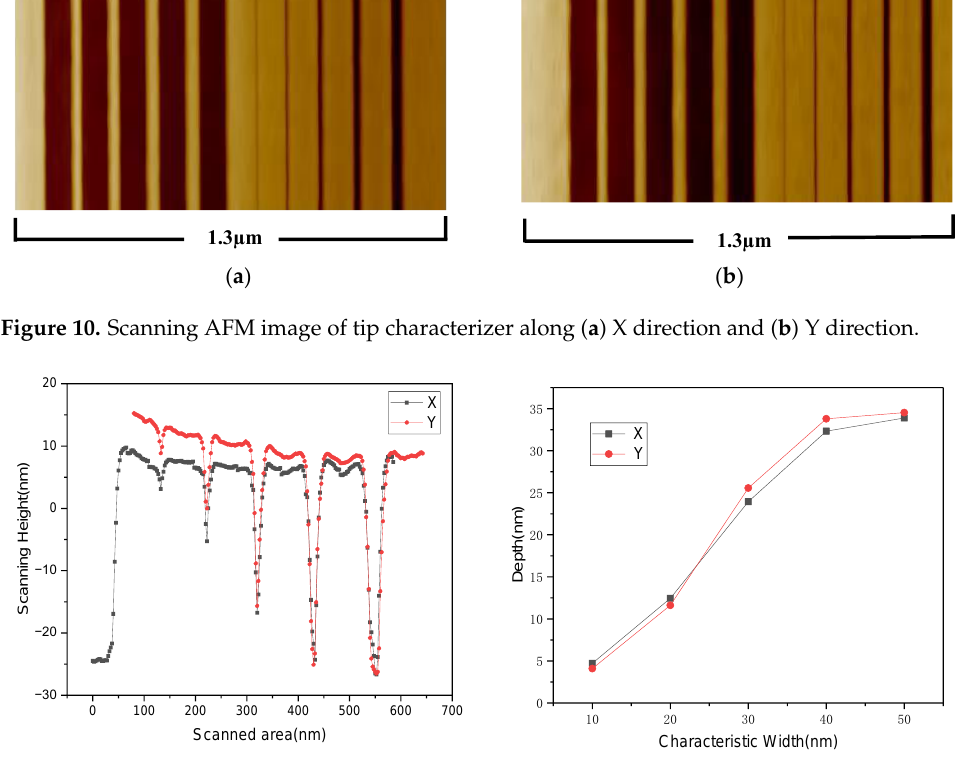
Figure 11. ( a ) Scanning AFM image profile of grooves part in tip characterizer; ( b ) Information corresponding to the depth and width of the tip.